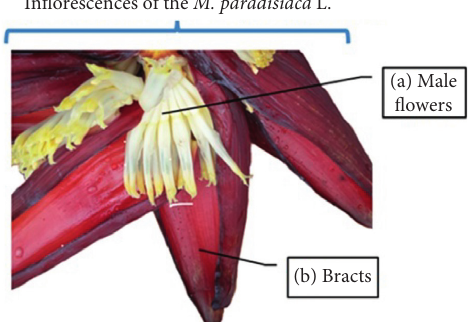
Figure 1: Inflorescence of M. paradisiaca L. (a) Male flowers and (b)